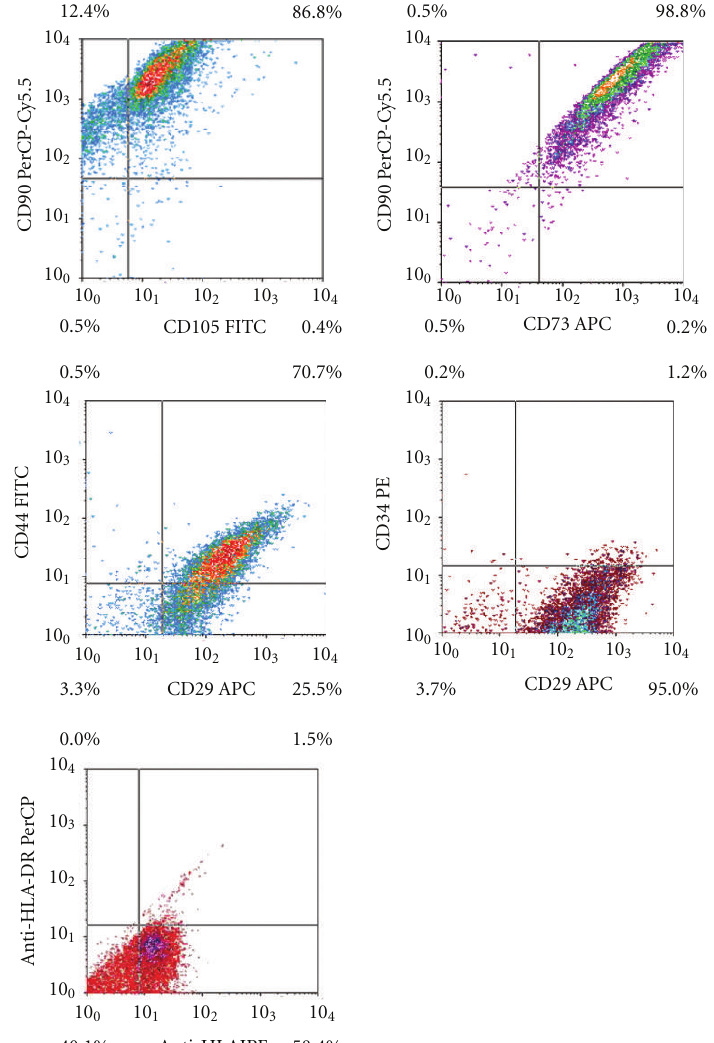
Figure 3: Flow cytometry analysis of surface-marker expression on umbilical cord mesenchymal cells, after one stage in culture. Flow cytometry reveals positivity for CD73, CD90, CD105, CD44, CD29 and a notable presence of negative double cells for both HLA-ABC and HLA-DR